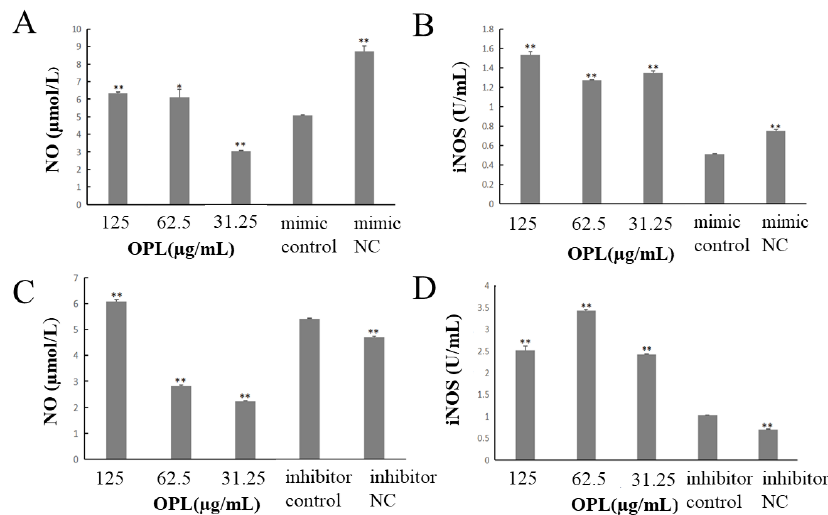
Figure 2. Influence of OPL on NO and iNOS contents. ( A ): Expression level of NO transfected with miR-4796 mimic; ( B ): expression level of iNOS transfected with miR-4796 mimic; ( C ): expression level of NO transfected with miR-4796 inhibitor; ( D ): expression level of iNOS transfected with miR-4796 inhibitor. Each value represents the mean ± SD ( n = 3). * p < 0.05, ** p < 0.01 compared with the control group.